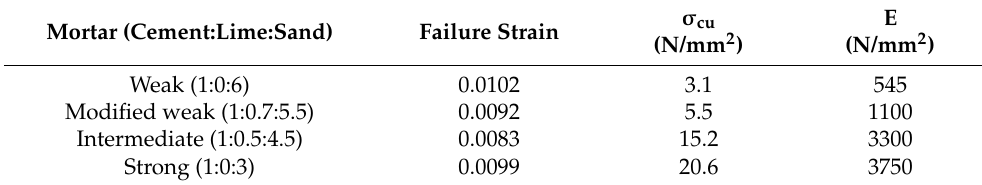
Table 4. Mechanical properties of